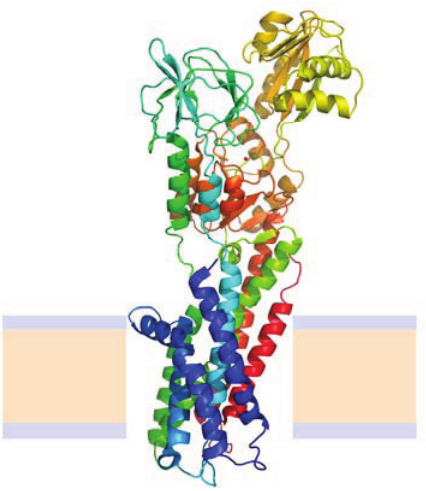
Figure 7. Structure of the Cooper transport ATPase from Legionella pneumophila (Protein Data Bank ID 3RFU). Alpha helices are represented by coiled ribbons, beta sheets by arrows and protein loops are shown as thin lines. The beige area represents the hydrophobic core of the membrane, while the light-indigo regions refer to the hydrophilic head groups of